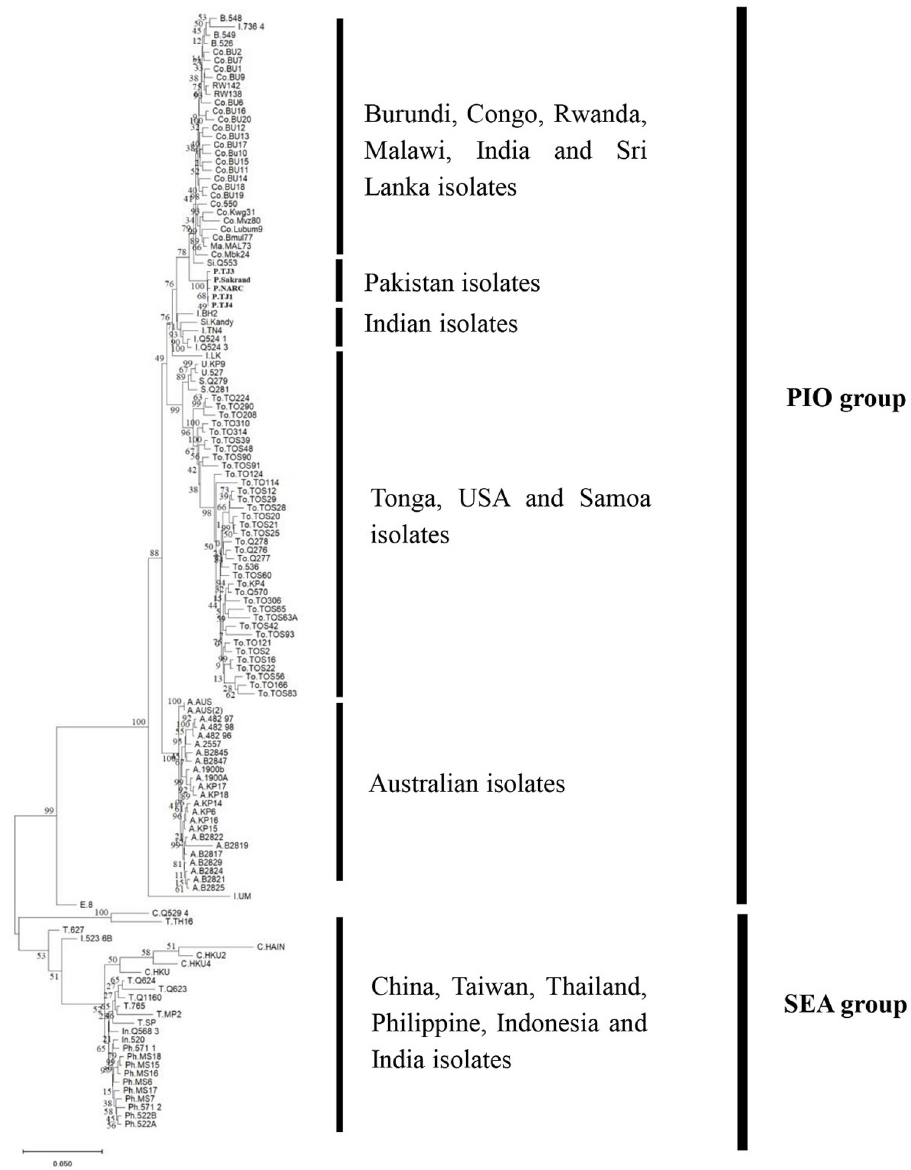
Fig 1. Maximum Likelihood phylogenetic analysis of Banana bunchy top virus entire genomes, showing the relationship of newly characterized BBTV genomes from Pakistan. Phylogenetic Maximum Likelihood analysis based on the concatenated nucleotide sequences of BBTV genomic components (R, U3, S, M, C, N together) indicates the evolutionary analyses of Pakistani isolates with the isolates from other parts of the world. The analysis involved 132 complete genome sequences. Each component is labelled with letters representing its geographic origin: Aus Australia, B. Burundi, C. China, Co. Congo, E. Egypt, I. India, M. Malawi, U. USA, S. Samoa, RW. Rwanda, Si. Sri Lanka, P. Pakistan, Ph. Philippines, T. Taiwan, To. Tonga, In. Indonesia, TH. Thailand. Pakistan isolates were shown in bold. The analysis showed two geographic regions in BBTV i.e Pacific Indian Ocean and Southeast Asia. Within the PIO Pakistan isolates showed homology with Indian, Samoa, Tonga Egypt, Australia and USA isolates. While SEA group includes isolates from China, Taiwan, Philippine, Thailand, Indonesia and a reassorted isolate of India.